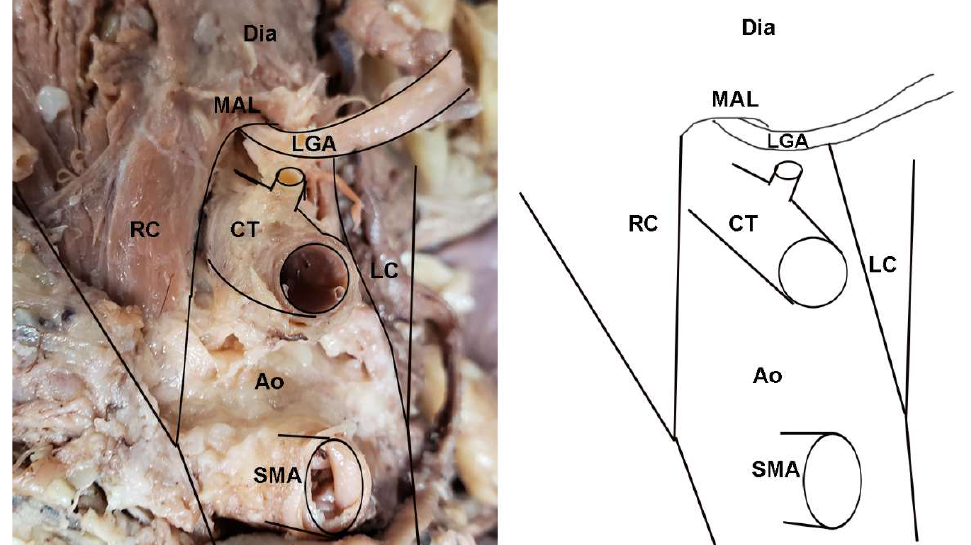
Figure 5. A notable variant displaying an uncommon branching of the left gastric artery (LGA) directly off the aorta in a cadaveric specimen: (a) Photo; (b) illustration. This example also demonstrates the direct overlap of the LGA by the median arcuate ligament. Abbreviations are as follows: Ao = aorta; CT = celiac trunk; Dia = diaphragm; LC = left crus of diaphragm; LGA = Left gastric artery; MAL = median arcuate ligament; RC = right crus of diaphragm; SMA = superior mesenteric artery.